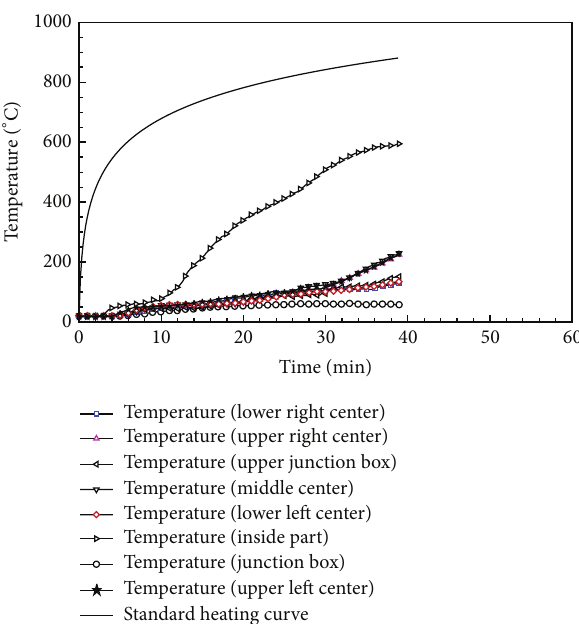
Figure 10: Time-temperature chart for the specimen in Test